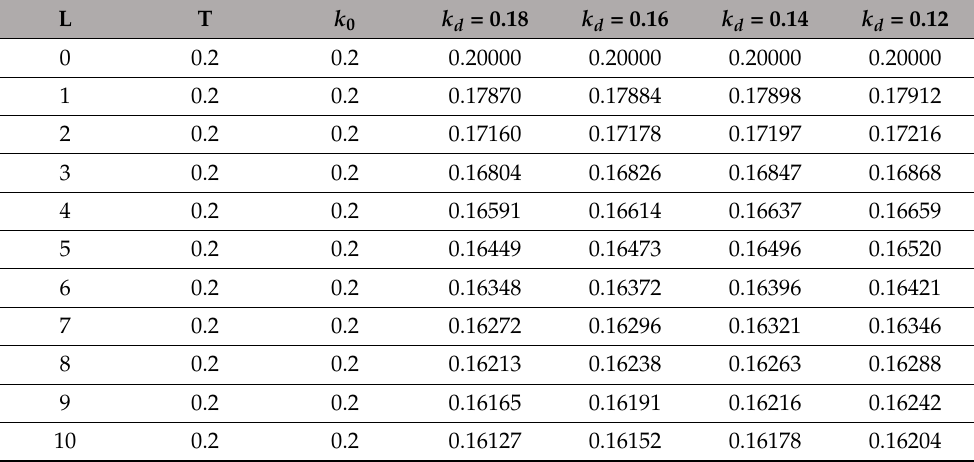
Table A4. Dependence of WACC on leverage level L at k 0 = 0.2, p = 4 and different k d = 0.18;